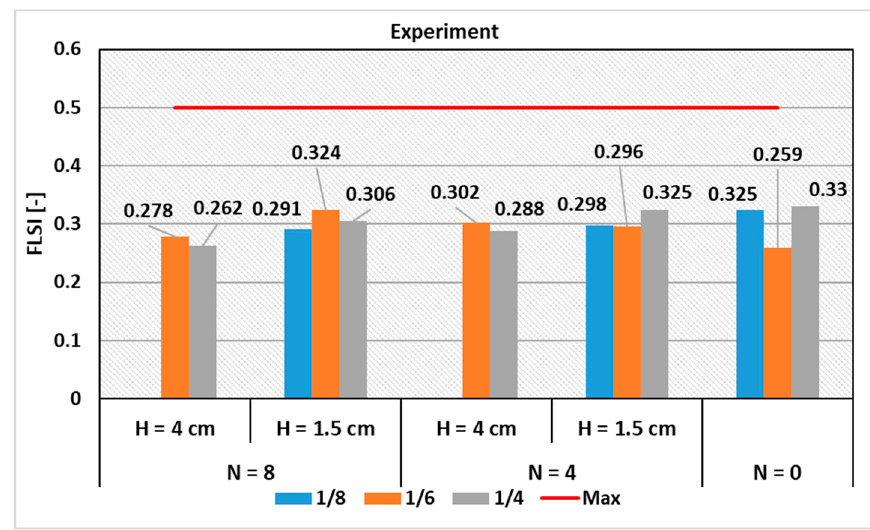
Figure 7. The front layer segregation index (FLSI) from experiments for the bi-density bed and for different drum filling ratios and baffles configurations.